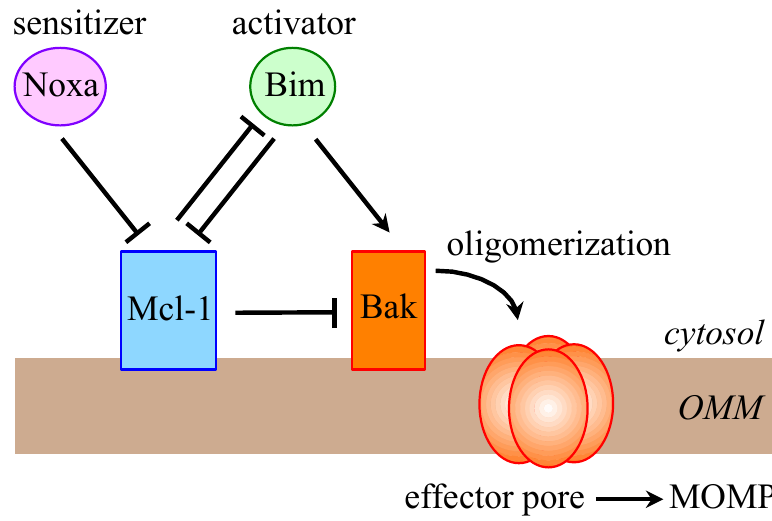
Figure 1. Unified model for Mcl-1 regulation of Bak-dependent mitochondrial outer membrane permeabilization (MOMP). Mcl-1 and Bak are constitutively anchored to the outer mitochondrial membrane (OMM). Mcl-1 can directly bind Bak and maintain it in